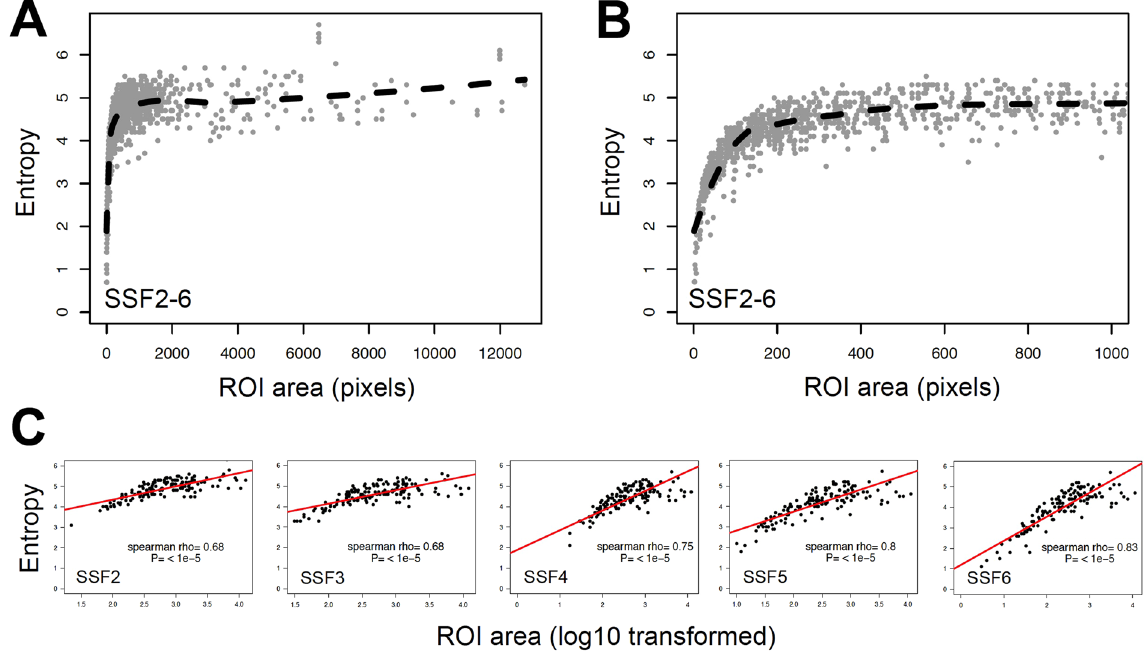
Figure 3. Entropy is a logarithmic function of the area of the region of interest. ( A , B and C ) are graphs showing the entropy across all SSFs ( A : ROI area from 0 to 12,000 pixels, B : zoom on ROI area smaller than 1,000 pixels) and for all SSF independently ( C ) in function of the area of the ROI in pixels within synchronous metastases #1. We observed that in every type of tissue (metastasis, normal psoas muscle, and blood in the aorta), entropy is a logarithmic function of the area of the ROI (P < 0.01, R2 = 0.47) rather than a linear one (P < 0.01, R2 =